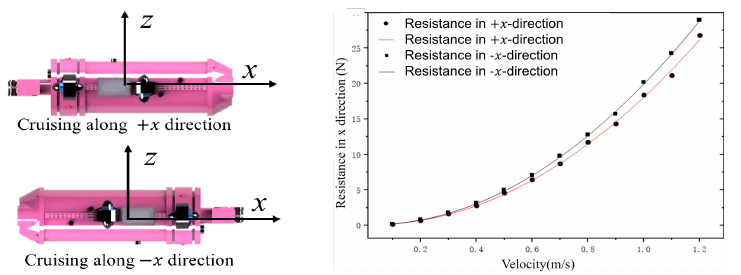
Figure 7. Left diagram shows the Shark-AUV cruising along ± x -directions in a body reference frame; the right one shows the curves of hydrodynamic resistances versus velocity of the AUV cruising along ± x